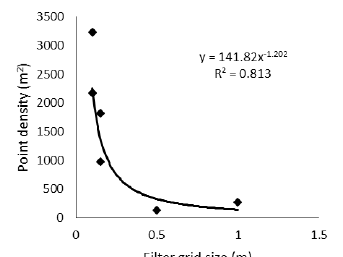
Figure 6. The relation between filter grid size and point density